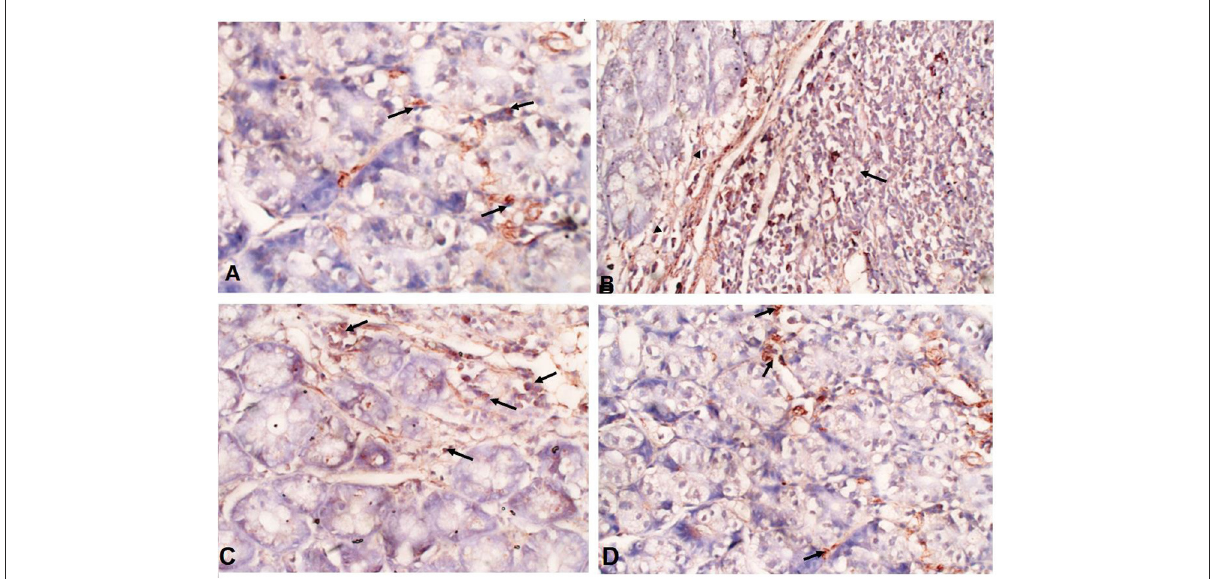
FIGURE6 A . annua treatment markedly reduced TGF- β expression in intestinal tissues of T. spiralis -infected mice. ( A – D) Immunohistochemical staining of TGF- β in intestinal tissues of different mice groups A. Representative image of intestinal tissue of uninfected mice showing weak expression of TGF- β (black arrows). (B) Representative image of intestinal tissue of infected untreated animals showing high expression of TGF- β in submucosal inflammatory cells (black arrows) and mucosal stromal cells (arrow heads). (C) Representative image of intestinal tissue of albendazole-treated animals showing reduction of TGF- β -positive mucosal stromal cells (black arrows). (D) Representative image of intestinal tissue of A. annua -treated mice showing marked reduction in TGF- β -positive mucosal stromal cells (black arrows). Magnification is 200x.